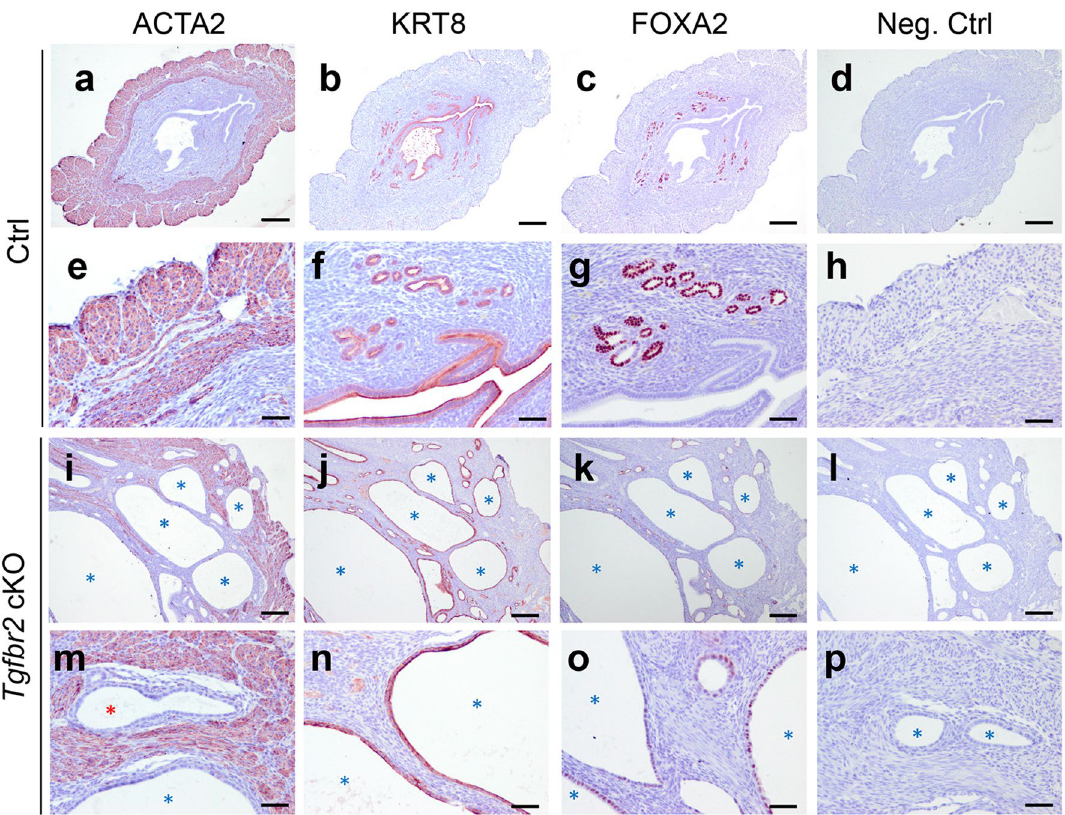
Figure 5. Formation of prominent cystic endometrium in Tgfbr2 cKO at 6 months of age. ( a–p ) Immunohistochemical staining of ACTA2, KRT8, and FOXA2 using uteri from 6-month-old Tgfbr2 cKO and controls. Representative negative controls using rabbit IgG are shown in ( d , h , l , p ). ( e – h and m – p ) Are higher magnification images for ( a – d and i – l ), respectively. Three independent mice were examined for each genotype. Scale bar equals 250 µm ( a – d and i – l ) and 50 µm ( e – h and m – p ). Cystic gland-like structures are indicated by